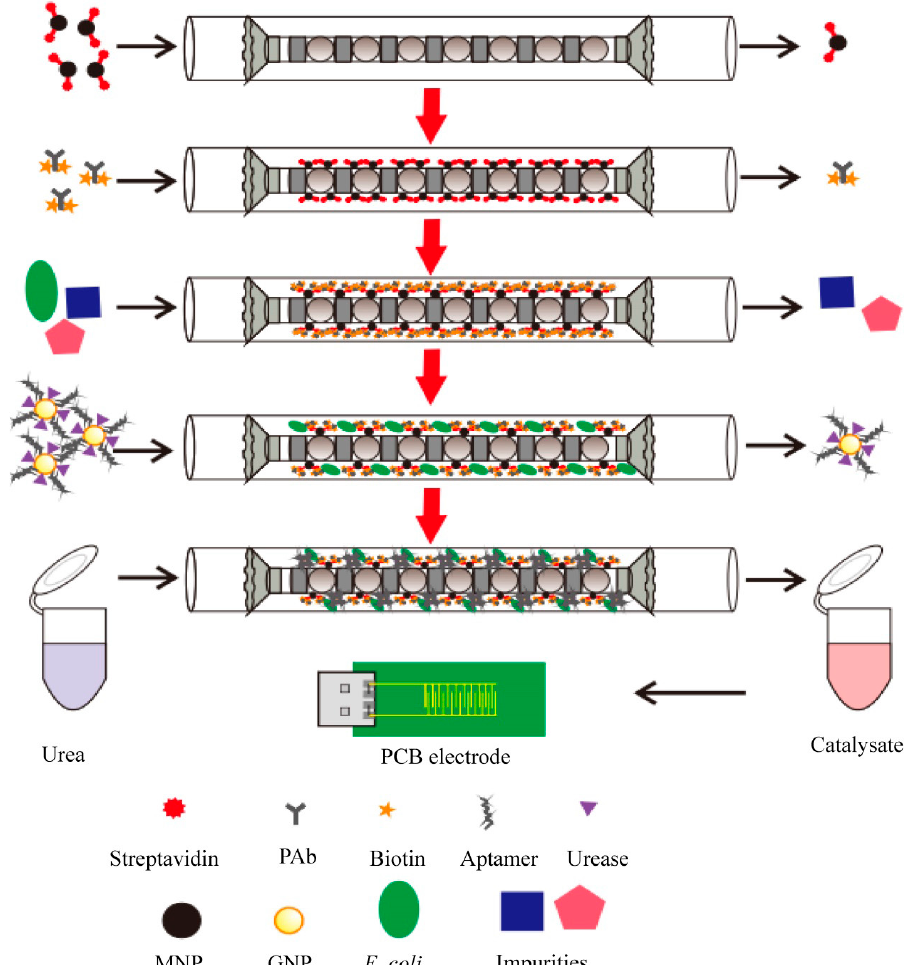
Figure 1. Electrochemical aptasensor for the detection of E. coli O157:H7 [54]. Reproduced